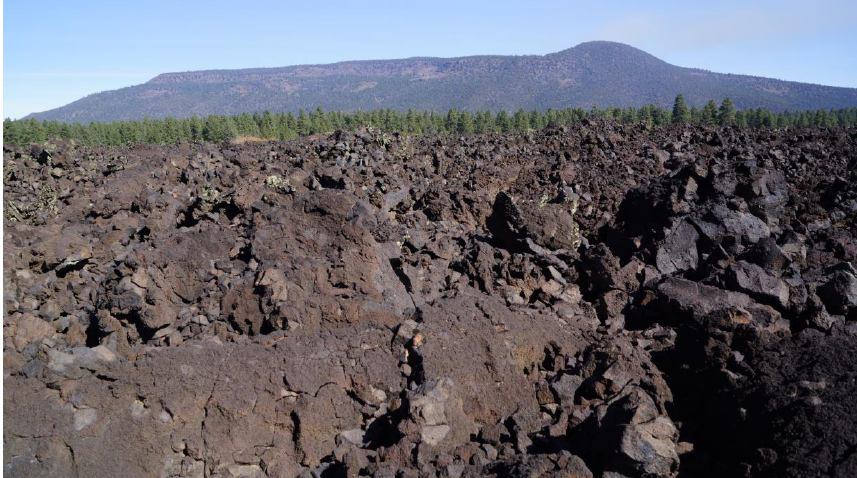
Figure 16. Mount Trumbull ( yïv ʷ i’ŋķarïRÏ ) Looking from Little Spring Lava Flow.